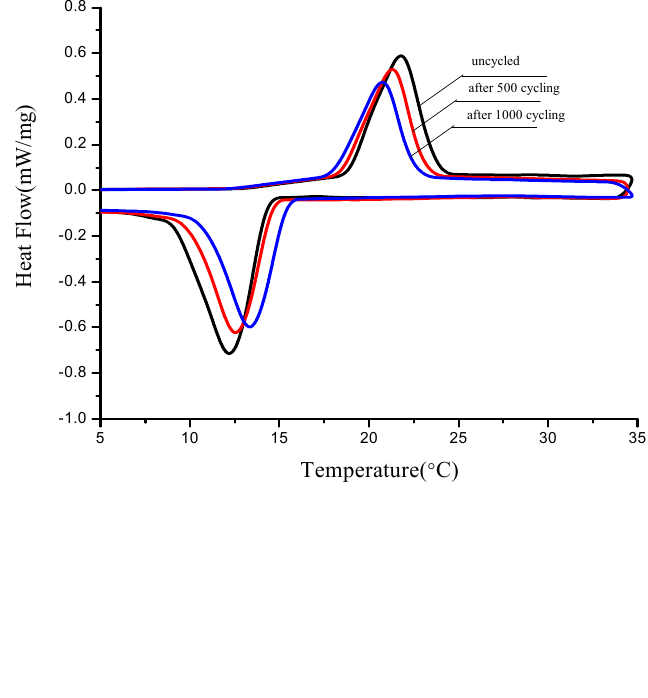
Figure 11. DSC curves of FS TD-CA PCM before cycling, after 500 and 1000